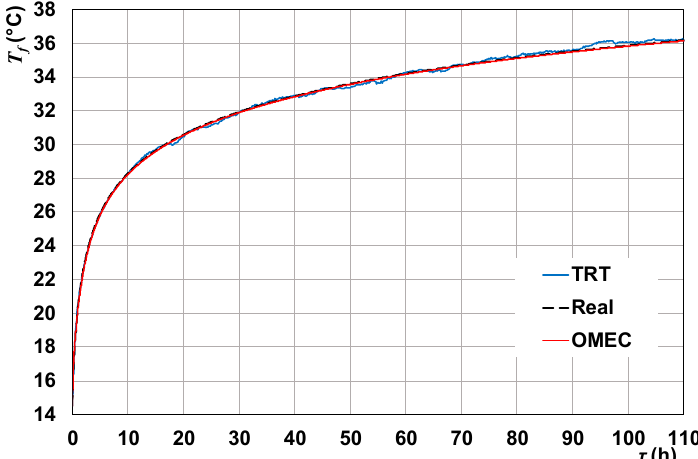
Figure 13. Plots of T f versus time yielded by the TRT [50] and by the simulations of the real BHE and of the OMEC.